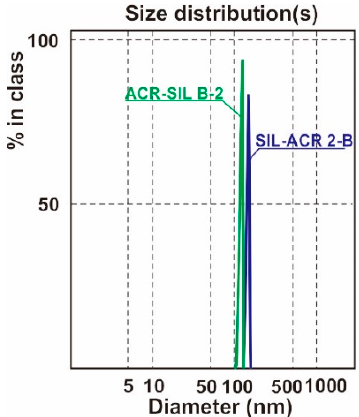
Figure 6. Comparison of particle size distribution patterns for SIL-ACR and ACR-SIL dispersions of the same composition of SIL and ACR parts. X-axis is logarithmic.